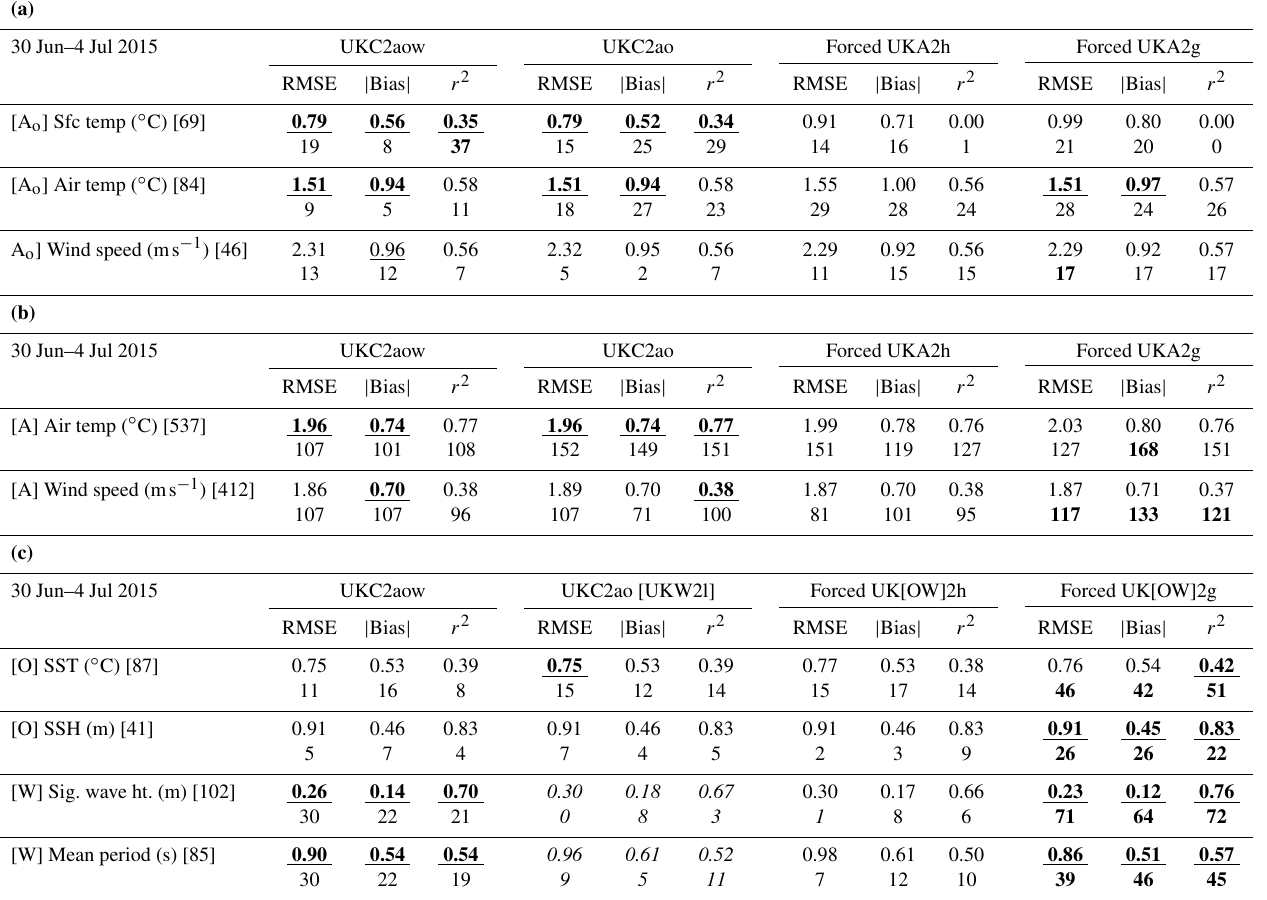
Table 9. Summary RMSE, bias and r 2 correlation coefficient statistics for the 30 June–3 July 2015 case study. Average statistics are computed from a comparison of model output against in situ observations of (a) all atmosphere [A] model variables, (b) atmosphere [A o ] model variables over sea grid cells only and (c) ocean [O] and wave [W] model variables. The relevant forced configuration with high-resolution forcing UKW2h, UKO2h and UKA2h are treated as the reference control model. Results showing a statistically significant difference from the reference according to a t test at the 95% confidence level are underlined. Those also showing an improvement against the reference are also in bold. Also listed for each variable under the horizontal lines for each metric is the number of sites for which the model configuration provided the best statistic relative to the other model configurations tested for this case. The configuration with the highest number of sites listed is highlighted in bold. Numbers in square brackets show the number of observation locations assessed for each